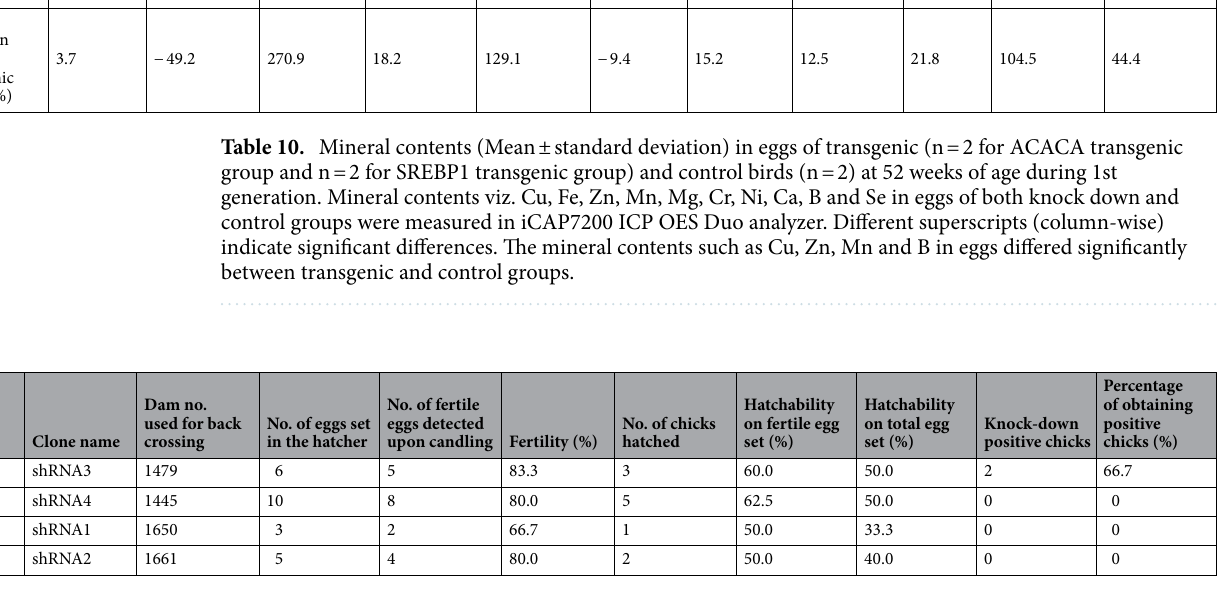
Growth, blood and biochemical parameters validated in the transgenic birds produced in 2nd generation. All the transgenic birds of 1st generation were of female, which were used further as female parents for back crossing with control broiler birds as male parents to produce back cross progenies to examine inheritance of the shRNA construct. The hatching schedule of the birds has described in Table 11. In back cross, two positive transgenic chicks for ACACA gene were hatched (Figs. 2, 3). But, in SREBP1 group, we did not have any positive transgenic chicks. Of two positive chicks, one was of male and another one was of female, but